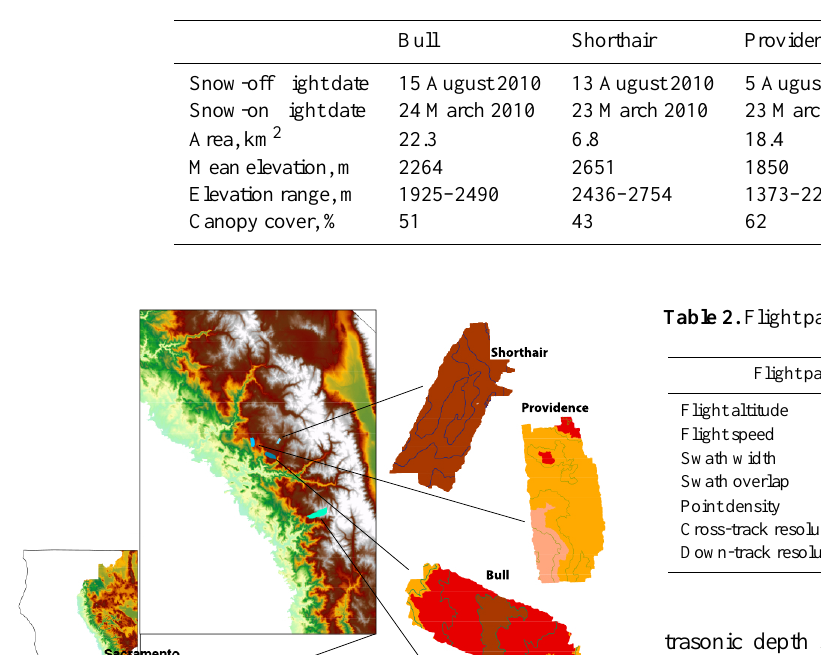
Table 1. Lidar data collection information.